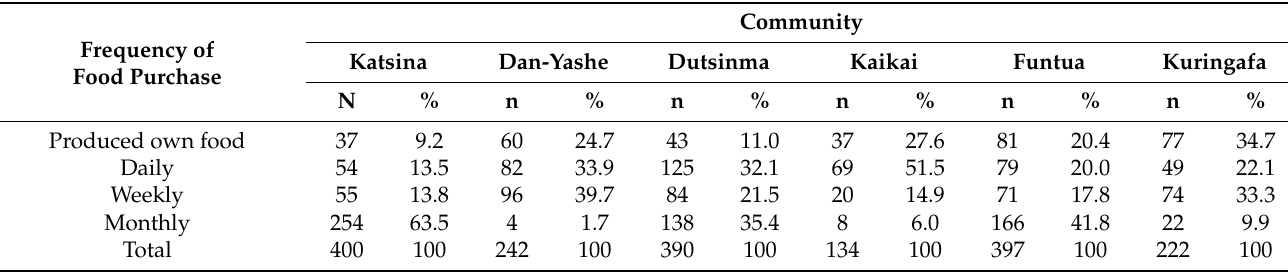
Table 10. Frequency of household food